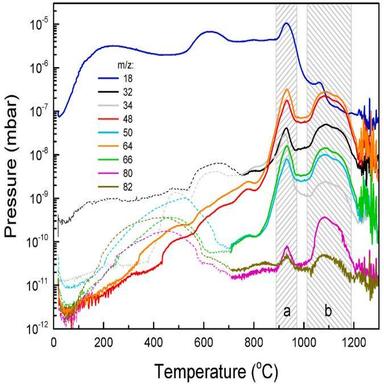
Sulfur-related RGA mass traces as a function of temperature (legend in figure). M/z = 32,34 are attributable to the two main S+ isotopes, (note the O2 + (m/z = 32) and H2S+ (m/z = 34) overlapping contributions), m/z = 48,50 to SO+, m/z = 64,66 to SO2 +, and m/z = 80,82 to SO3 +. The dashed parts of each trace represent the ranges with significant background from other compounds. The hatched areas (a) and (b) denote zones with different H2O/S/SO/SO2/SO3 proportions, alluding to different reactions – related